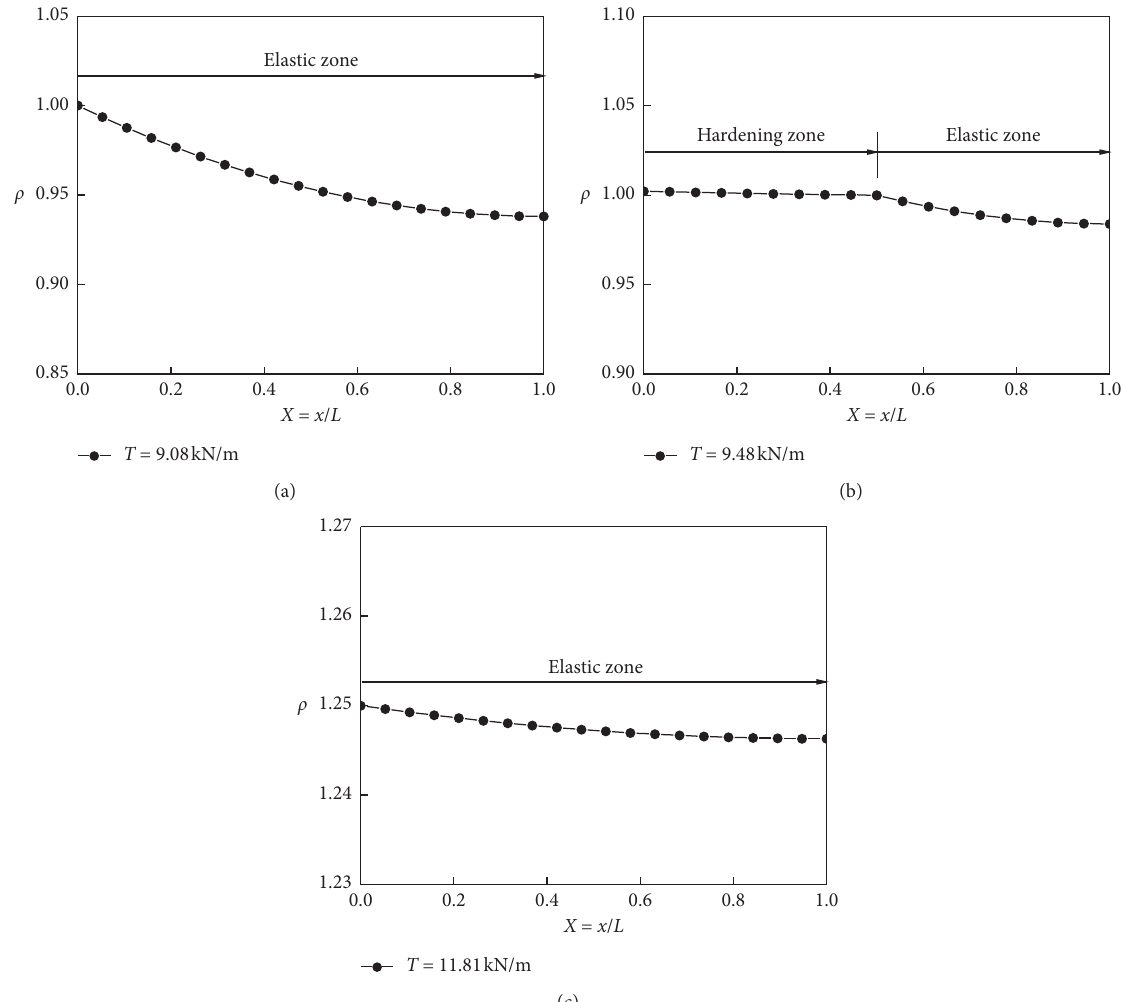
Figure 12: Evolution of the interfacial shear stress in different stages of the pull-out process of the reinforced tailings (strain-hardening reinforcement): (a) elastic stage; (b) elastic-hardening transition stage; (c) pure hardening